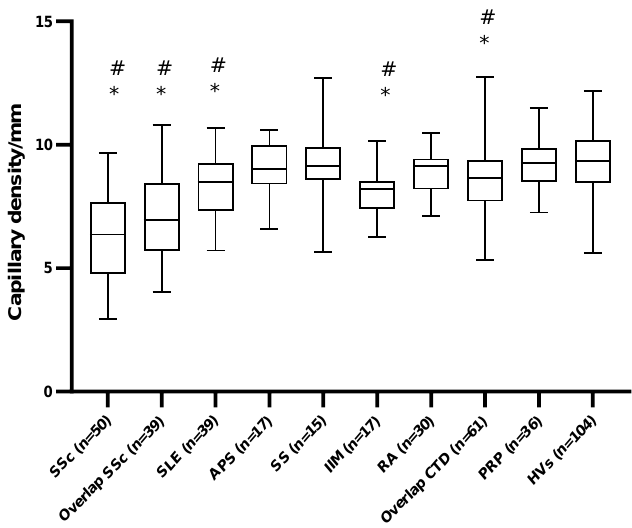
Figure 1. Capillary density in the investigated groups of patients. * p < 0.05 or lower significance compared with PRP. # p < 0.05 or lower significance compared with HV. SSc, systemic sclerosis; SLE, systemic lupus erythematosus; APS, antiphospholipid syndrome; SS, Sjögren’s syndrome; IIM, idiopathic inflammatory myositis; RA, rheumatoid arthritis; CTD, connective tissue disease; PRP, primary Raynaud’s syndrome; HVs: healthy volunteers. Table 3. Comparison of capillary density and SSc pattern between patients with and without Raynaud’s phenomenon in patients with different connective tissue